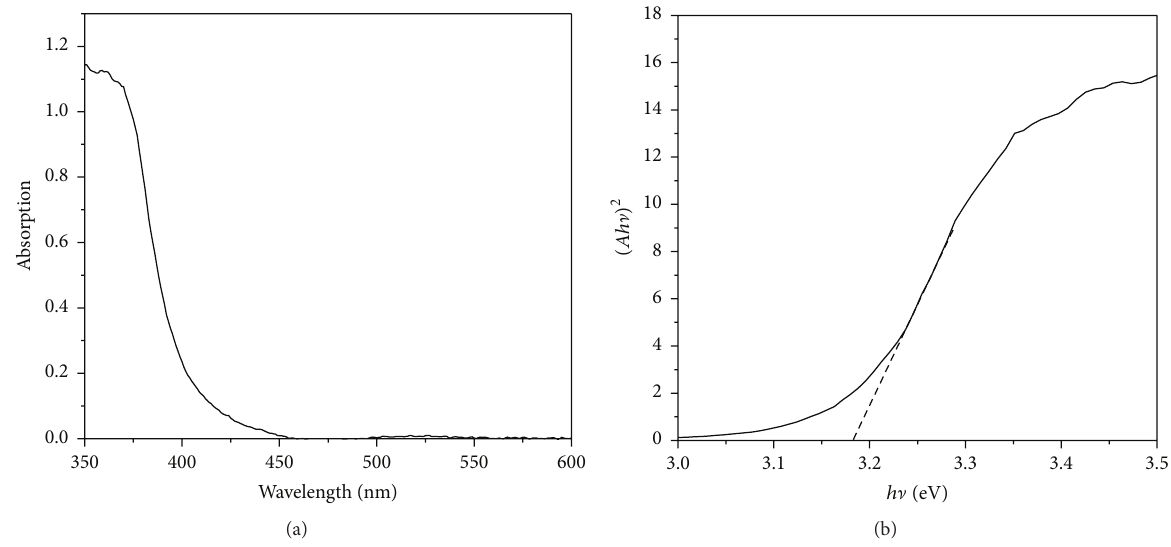
Figure 4: (a) UV-vis absorption spectra of the prepared zinc oxide nanomaterials and (b) the plots of (𝐴ℎ ] ) 2 versus the photon energy ( ℎ ] ).